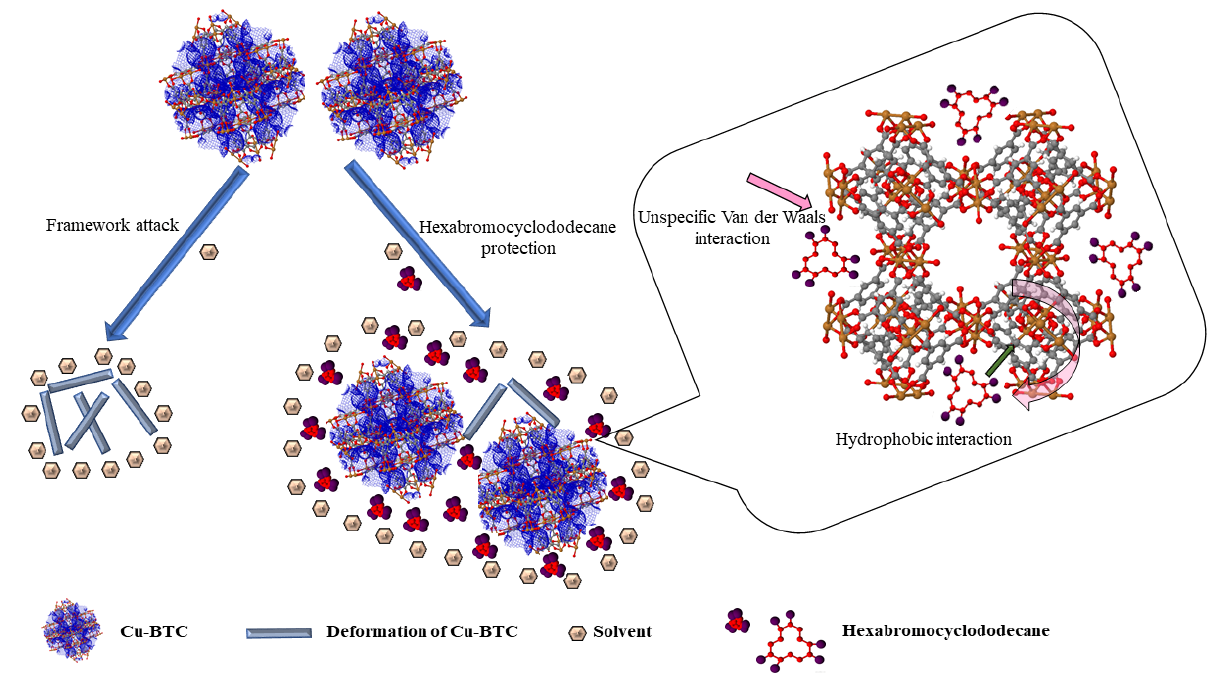
Figure 3. Adsorption mechanism of HBCD onto Cu-BTC [46].